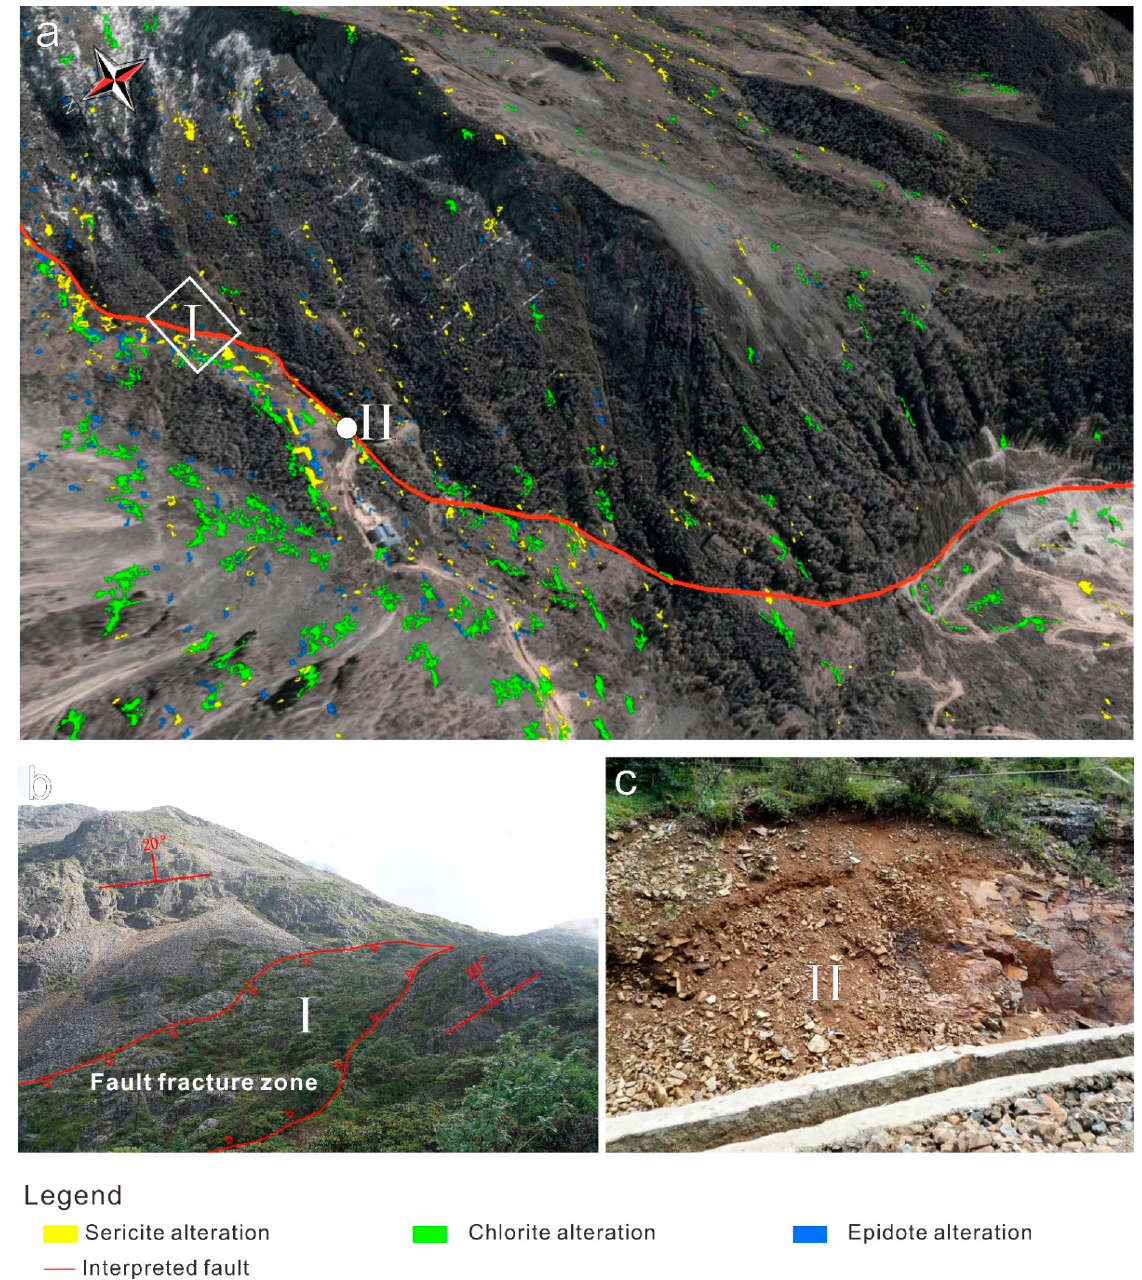
Figure 7. 3D reconstruction of the remote sensing image and the field validation of the speculated fault. ( a ) 3D reconstruction of the remote sensing image and the speculated fault; ( b ) the field validation of the fault trace; ( c ) the outcrop of the fault).